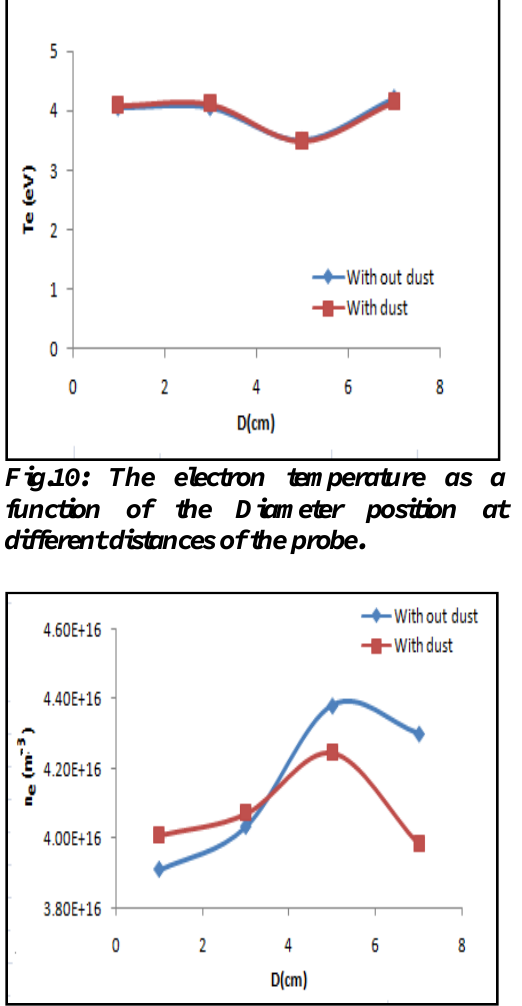
Fig.11: The electron density as a function of the Diameter position at different distances of the probe.